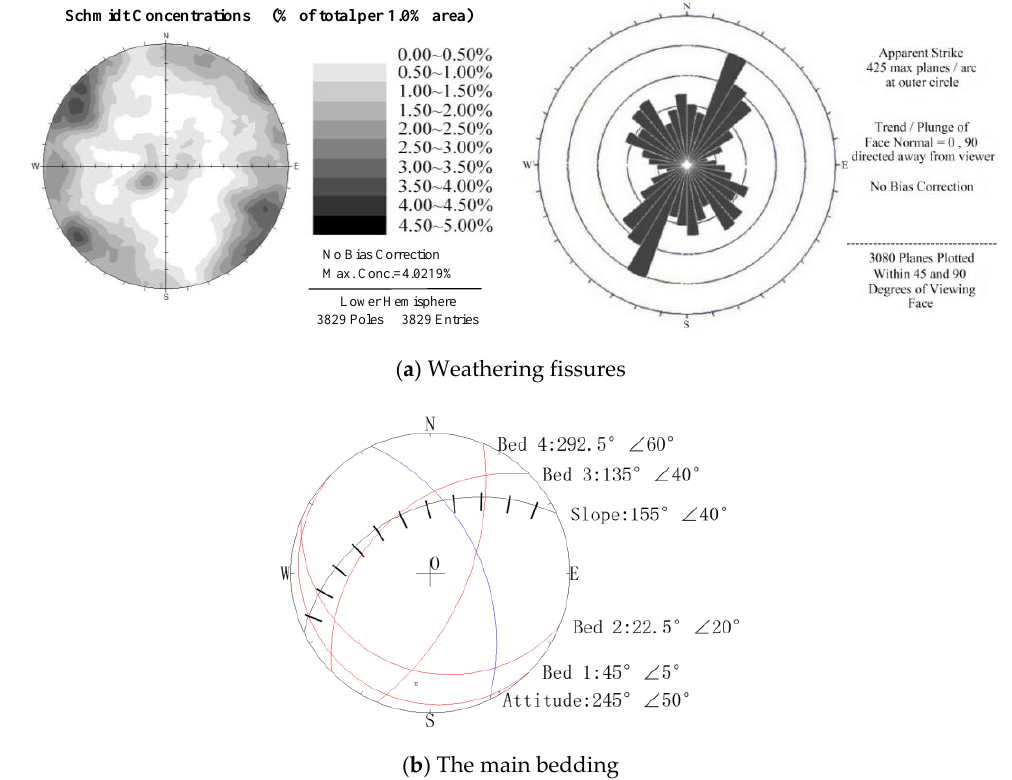
Figure 6. Average distribution of red-bed superficial weathering fissures and main bedding in northern Guangdong province in South